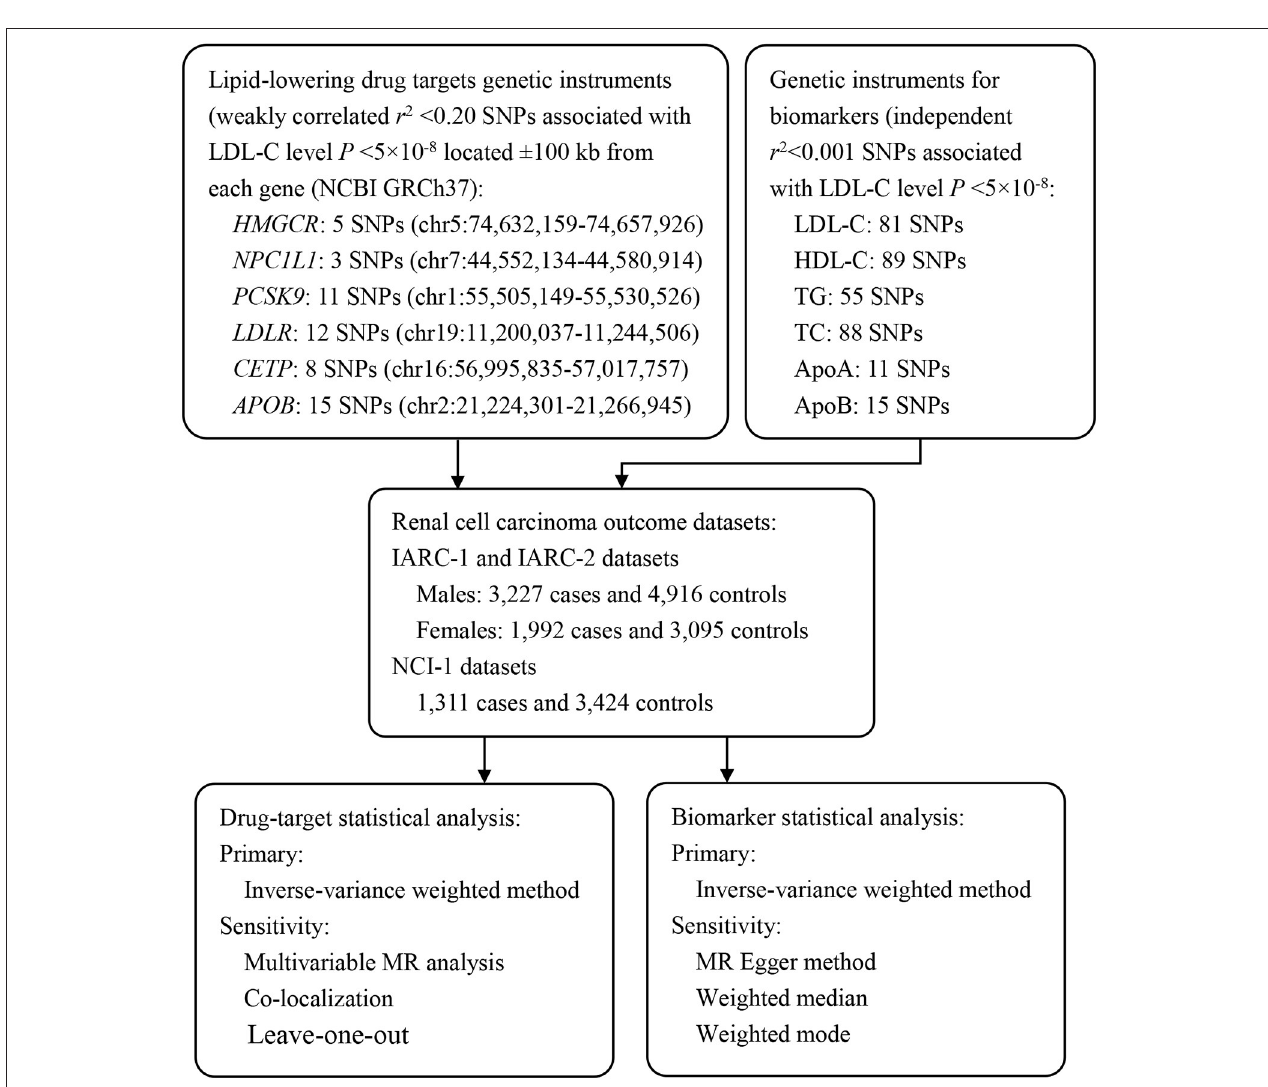
FIGURE 1 | Overview of the study design. To construct instruments for drug targets and circulating biomarkers, summary genetic association data with LDL-C, HDL-C, TG, and TC were obtained from a European ancestry GWAS conducted by GLGC ( N = 188,577). These SNPs were then matched with RCC outcome datasets to obtain SNP-outcome associations. After matching SNPs across traits and aligning them into the same effect allele, Mendelian randomization analyses were performed using the IVW method as the primary analyses, and various sensitivity analyses were applied to test Mendelian randomization